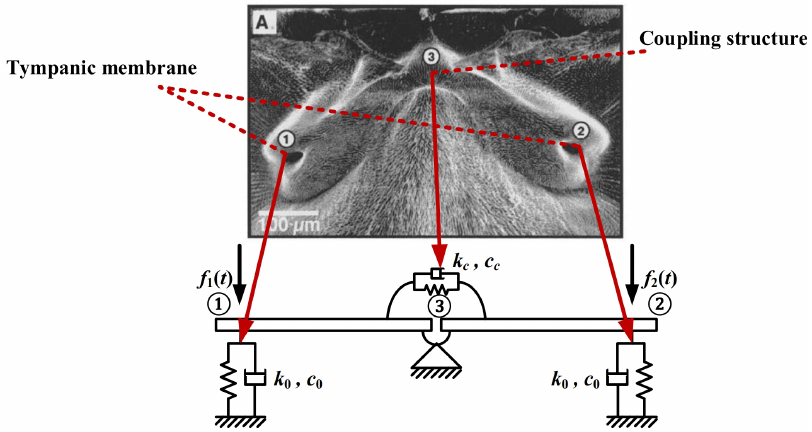
in Figure 1. x i ( t , φ ) , i = 1, 2 and y i ( t , φ ) , i = 1, 2 are the input and output signals, whereas